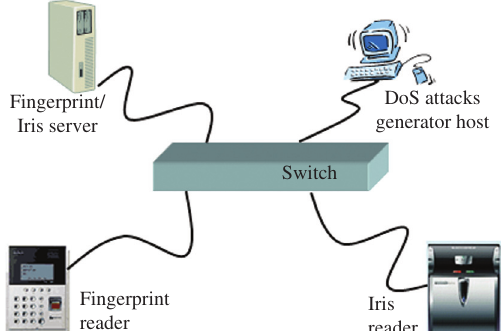
Figure 6. Network Architecture.